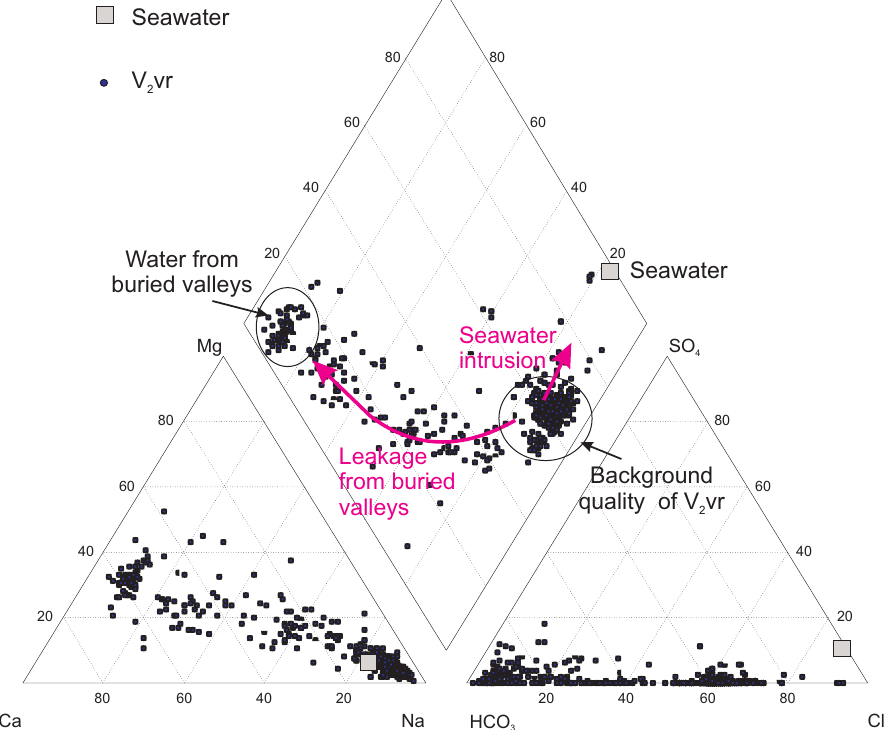
Fig. 12. Conceptual model of the formation of the chemical composition of the V 2 vr groundwater